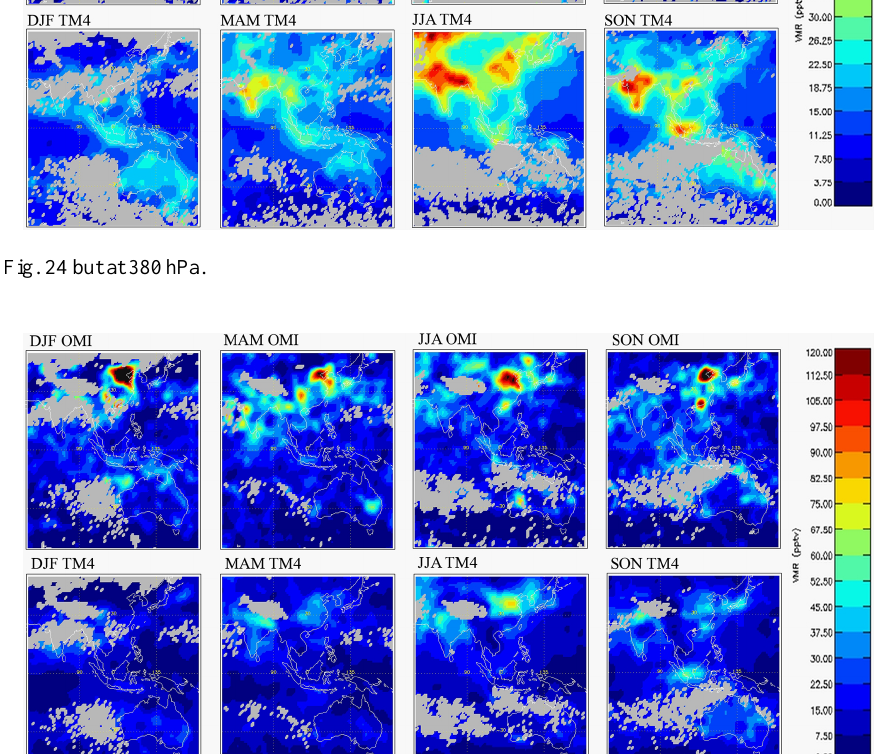
Figure 26. Same as Fig. 24 but at